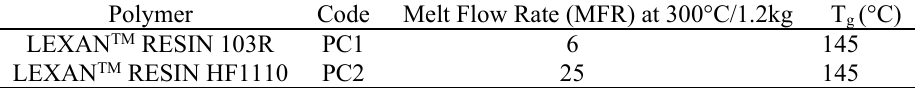
Table 1. Grades of PC samples used in this